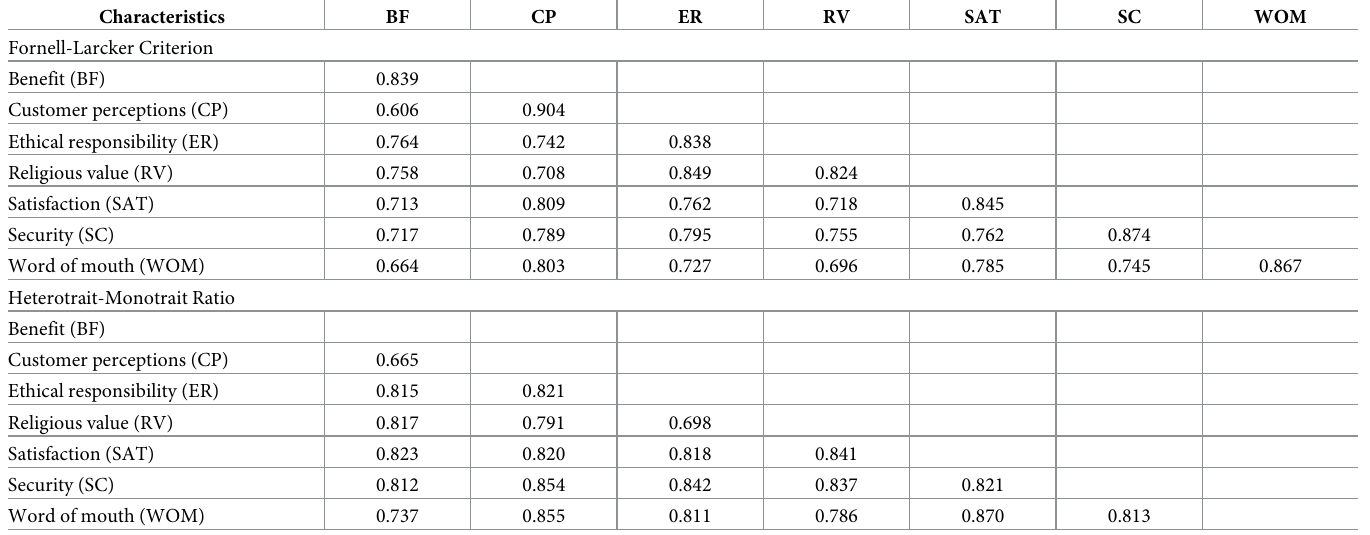
Table 4. Discriminant